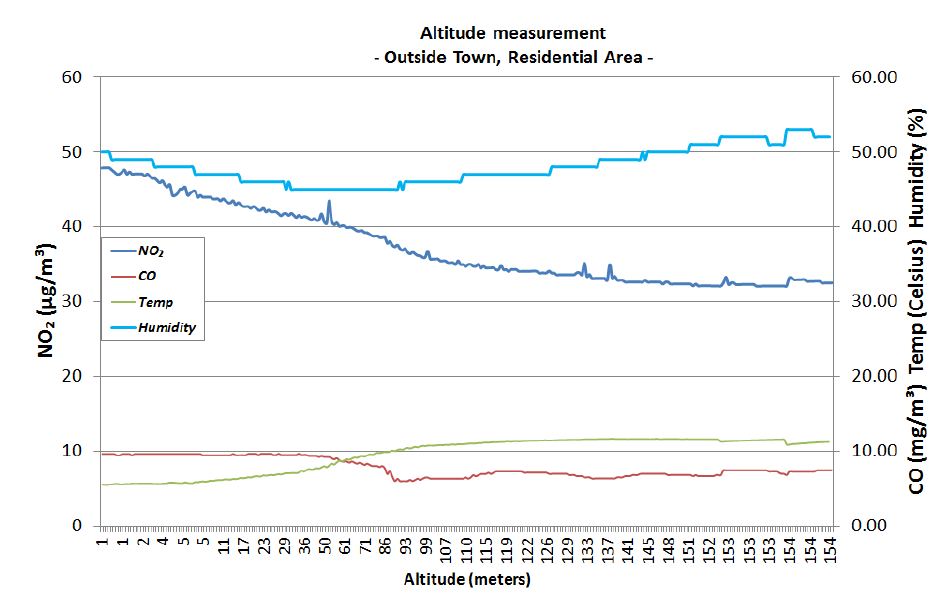
Figure 13. City peripheral residential zone, from ground level to 150 m in